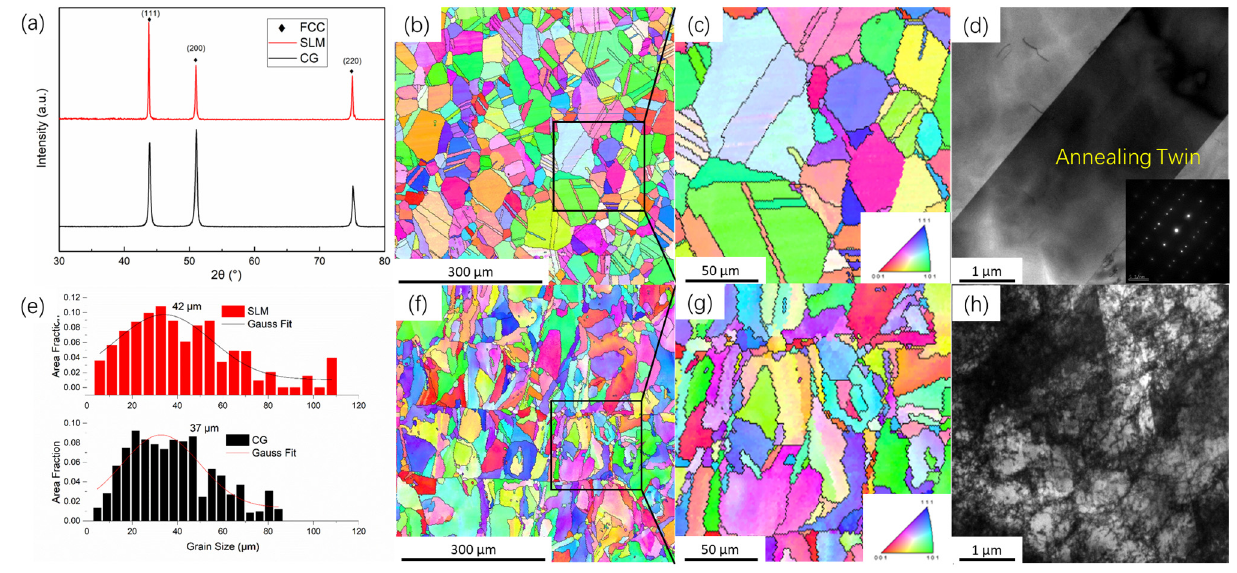
Figure 1. Microstructures of the As-Cast and As-SLM HEAs. ( a ) XRD results. ( b , c ) EBSD IPF maps of the As-Cast HEA. ( d ) Bright field TEM image showing low dislocation density and annealing twin in the As-Cast HEA. ( e ) Calculated grain size distribution. ( f , g ) EBSD IPF maps of the As-SLM HEA. ( h ) Bright field TEM image showing dislocation cell structures in the As-SLM HEA.